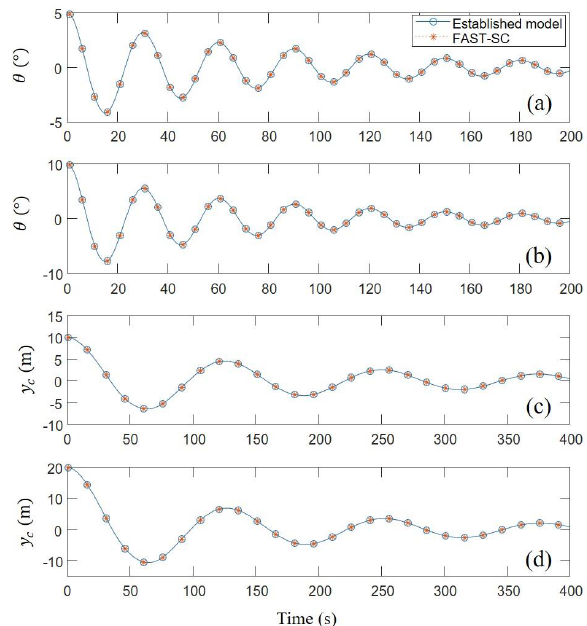
Figure 2. Free decay response comparison. ( a ) pitch angle with the initial value of 5 ◦ ; ( b ) pitch angle with the initial value of 10 ◦ ; ( c ) surge motion with the initial value of 10 m; ( d ) surge motion with the initial value of 5 m.